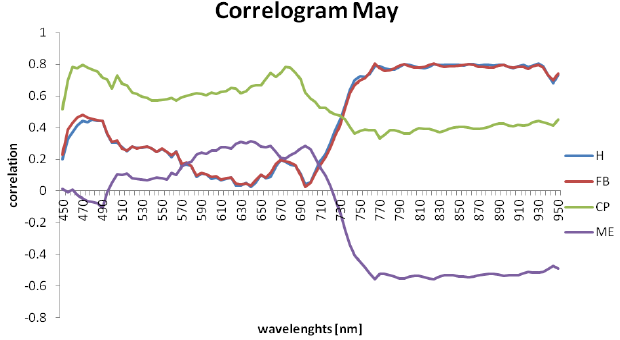
Figure 6. Correlogram between spectral variables of the hyperspectral dataset and height (H), fresh biomass (FB), crude protein (CP), and metabolic energy (ME) for the May